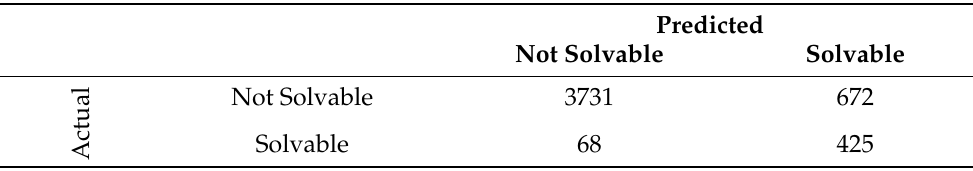
Table 2. Confusion matrix for evaluating the decision tree (Figure 4) on the test dataset. Setting of random annealing time and random UTC